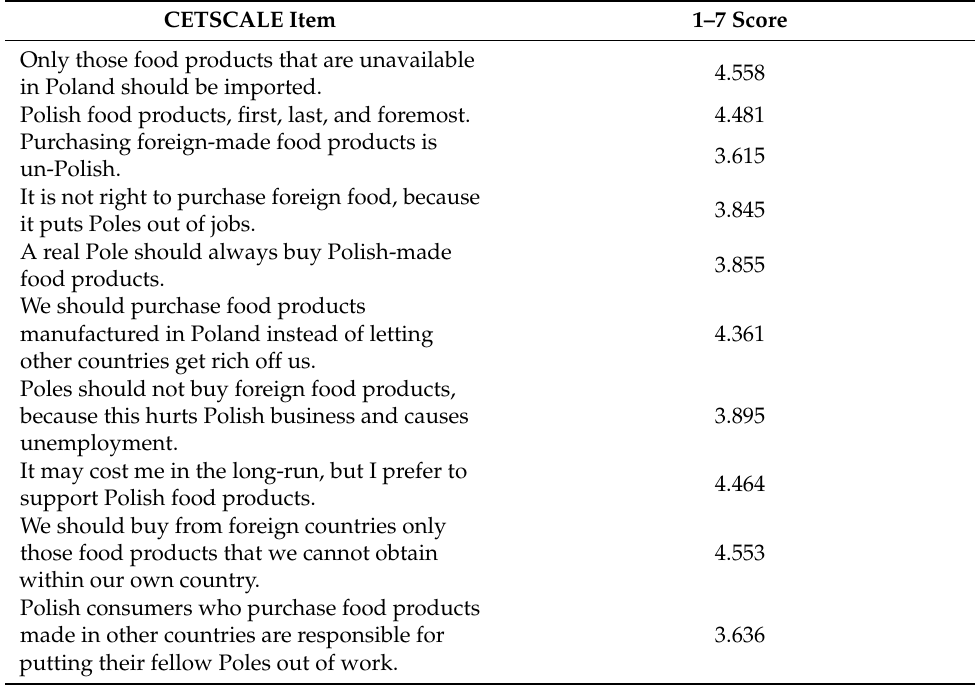
Table 2. Consumer ethnocentrism in the food market (10-item